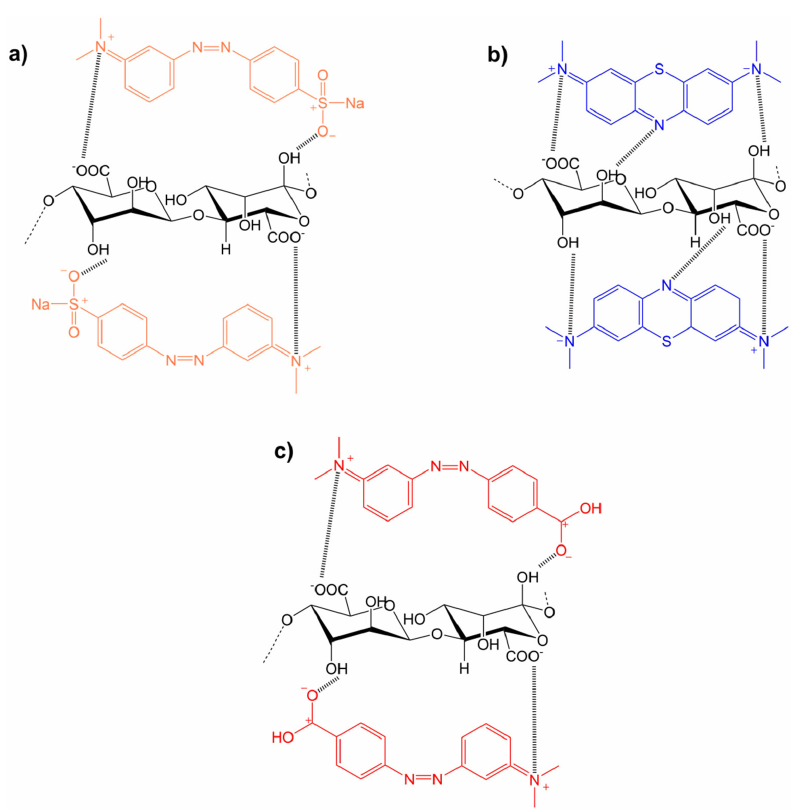
Figure 12. FTIR analysis of CT- Sargassum spp. after filtration. Five different zones of interest are marked by dashed lines (I, II, III, IV and V).